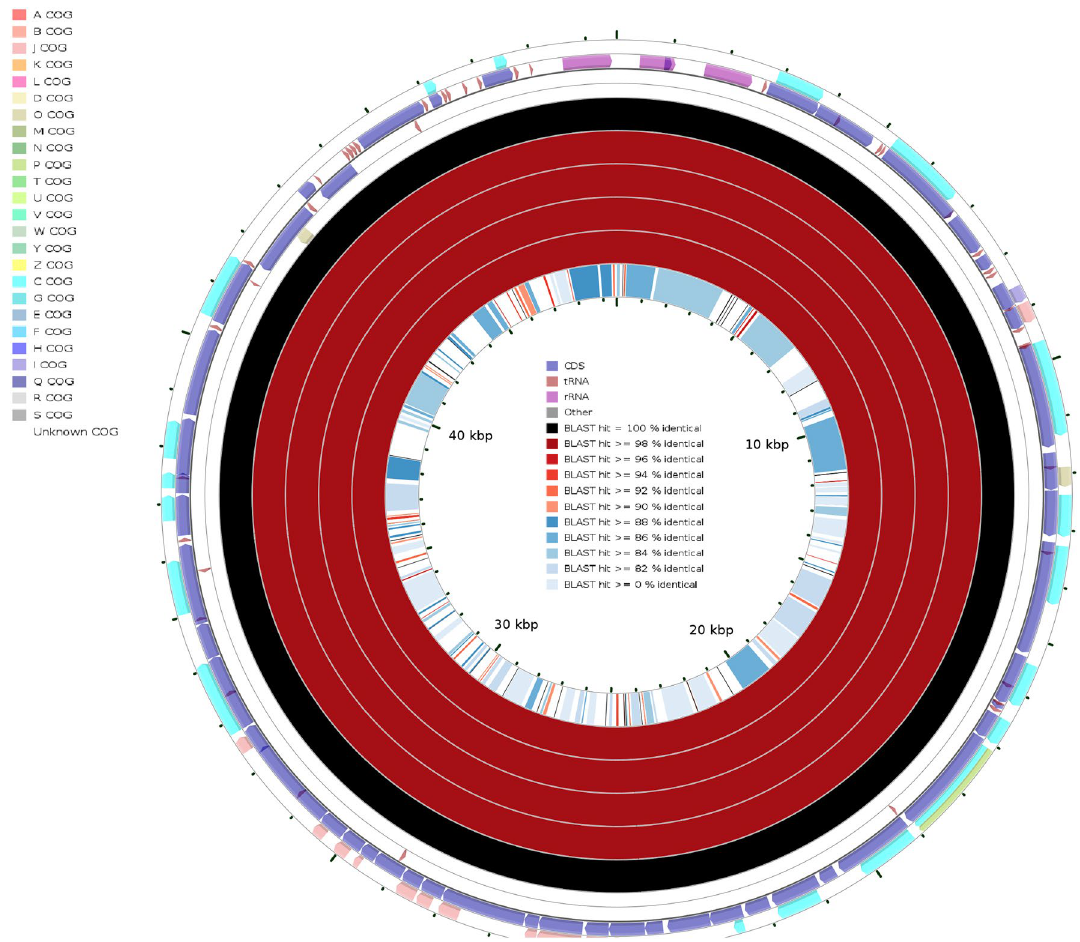
Figure 7. Graphical representation of BLAST results using N. fowleri isolate AY27 (MZ461463) mitochondrial DNA as a reference and other Naegleria species mitochondrial DNA as a queries. From the circle inward: the first ring represents the COG (Clusters of Orthologous Groups of proteins) grouping, second, third and fourth rings consist of CDS, tRNA, rRNA and other genes; fifth ring in black color represent the reference and six to nine rings are representing five N. fowleri species and the tenth ring is for N. gruberi